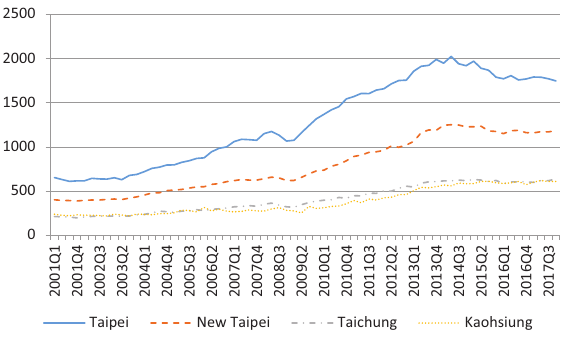
Figure 1. Average house